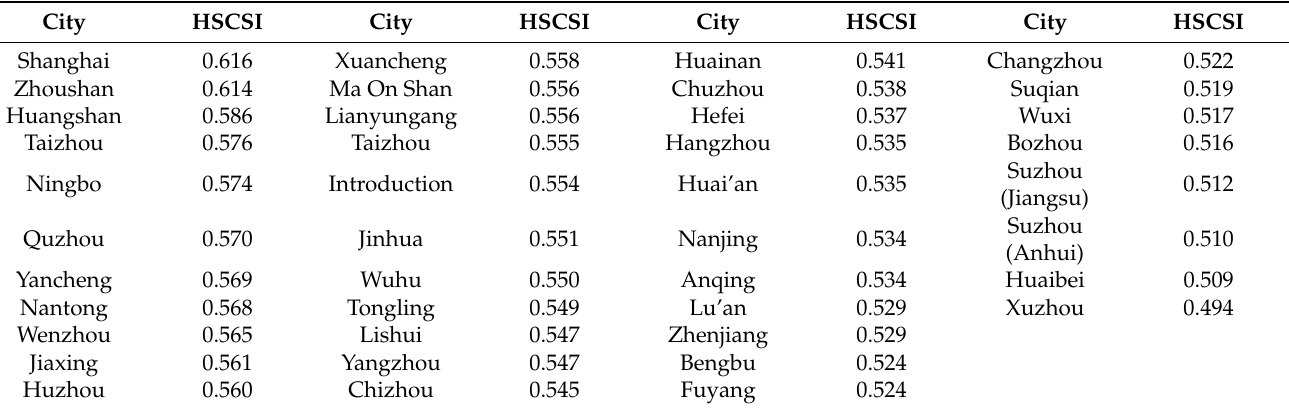
Table 3. Average values of HSCSI in YRD.